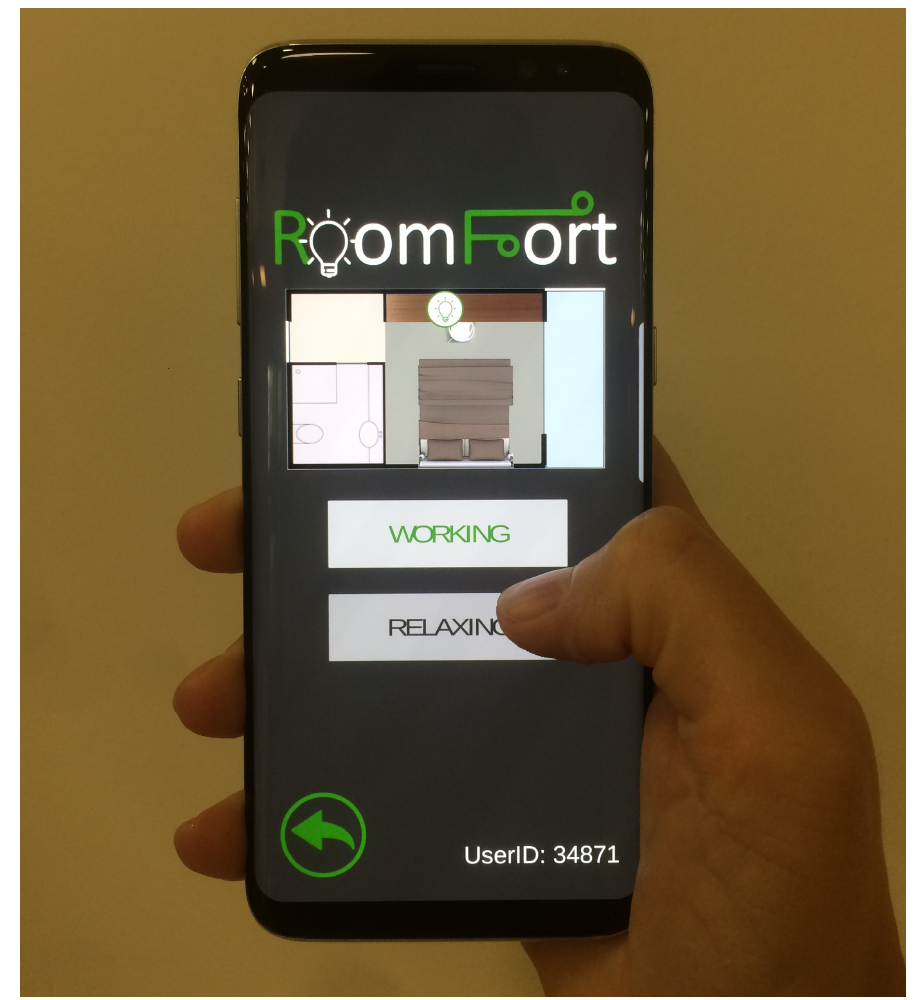
Figure 8. A screenshot of the RoomFort application for Android devices. The user (identified by his/her own ID number) selects an